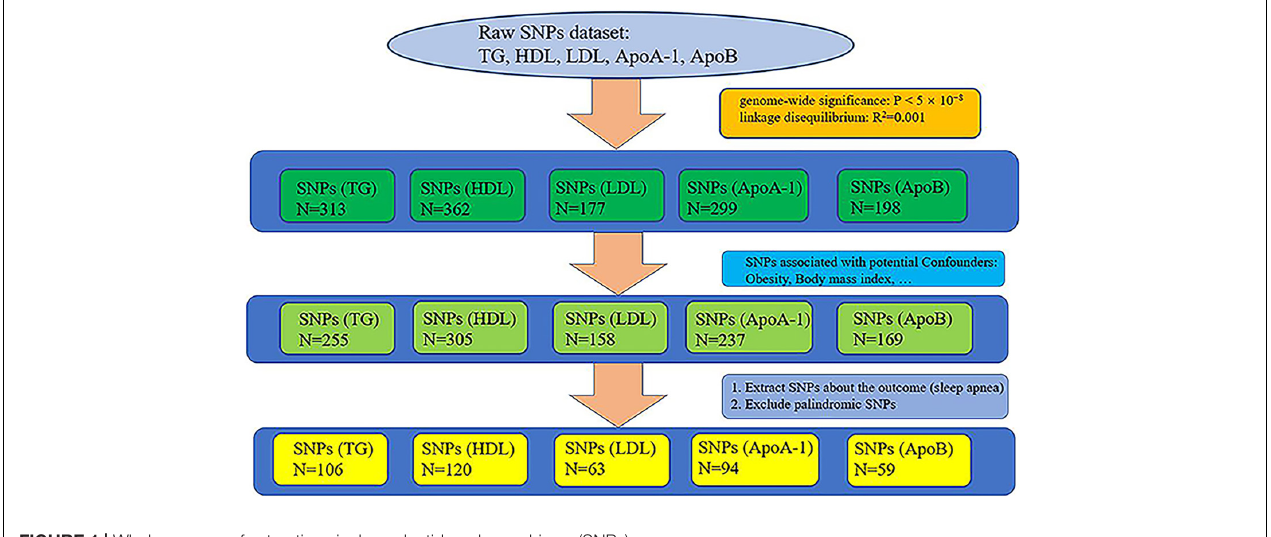
FIGURE 1 | Whole process of extracting single nucleotide polymorphisms (SNPs).